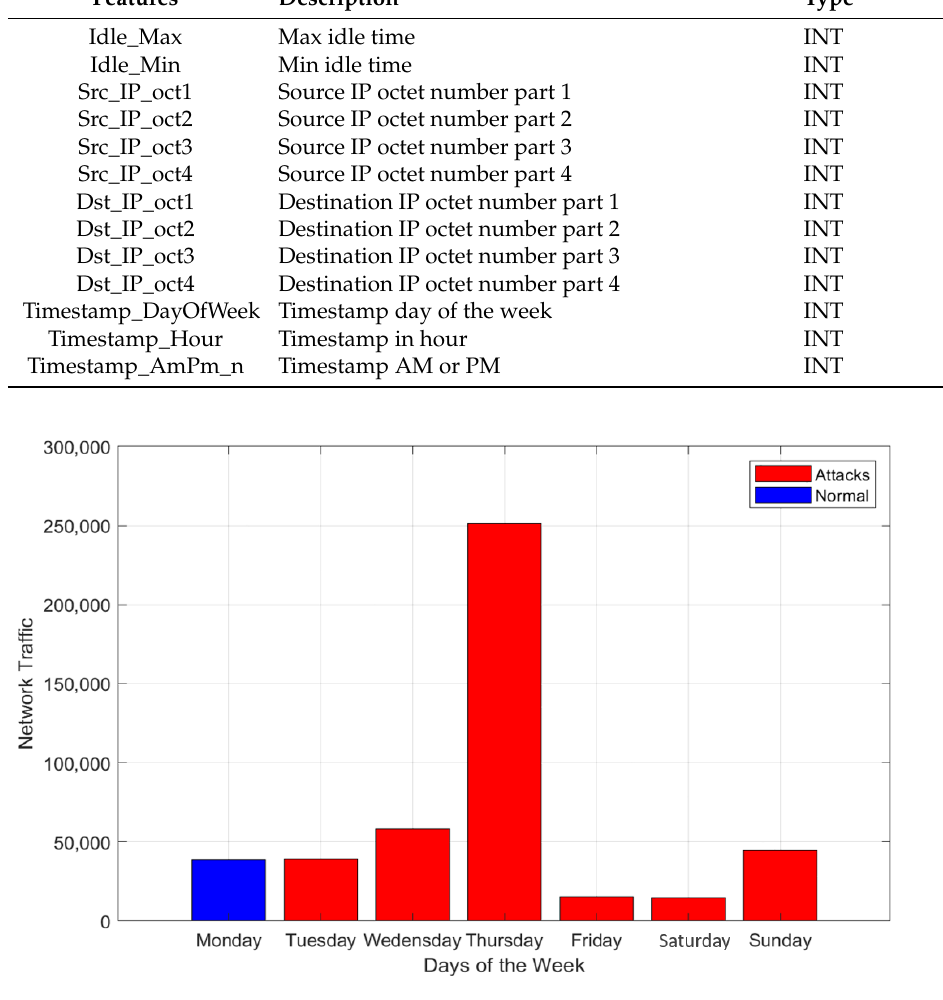
Figure 9. Network traffic during the week.